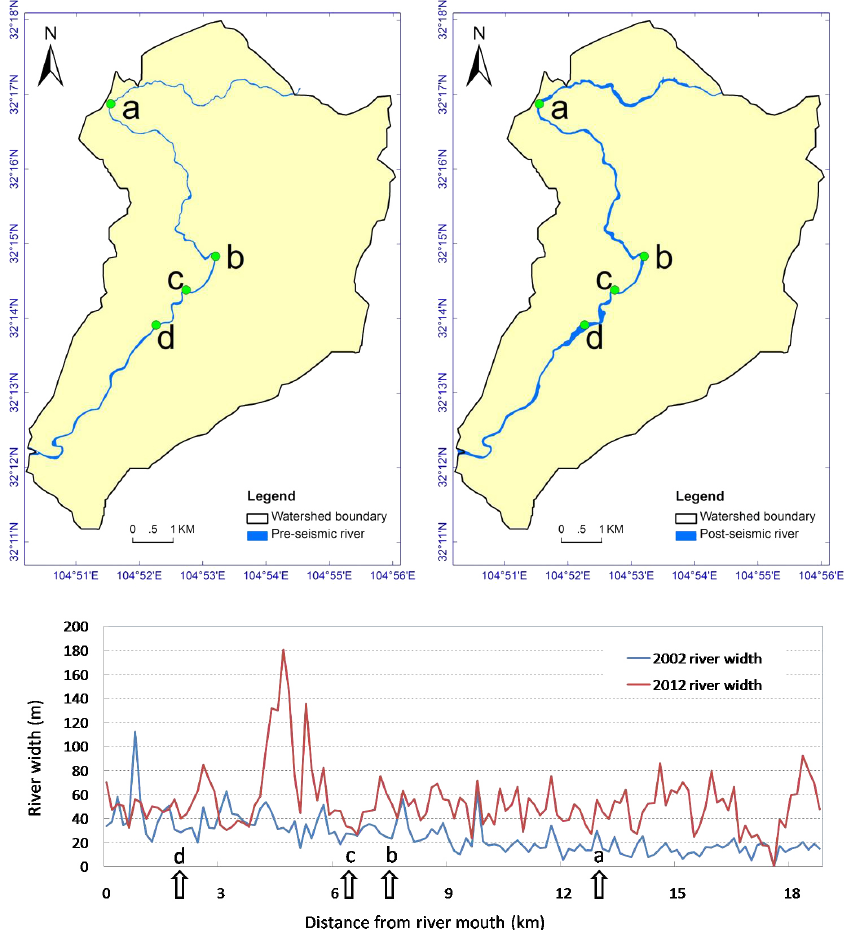
Figure 7. Riverbed width change before and after the